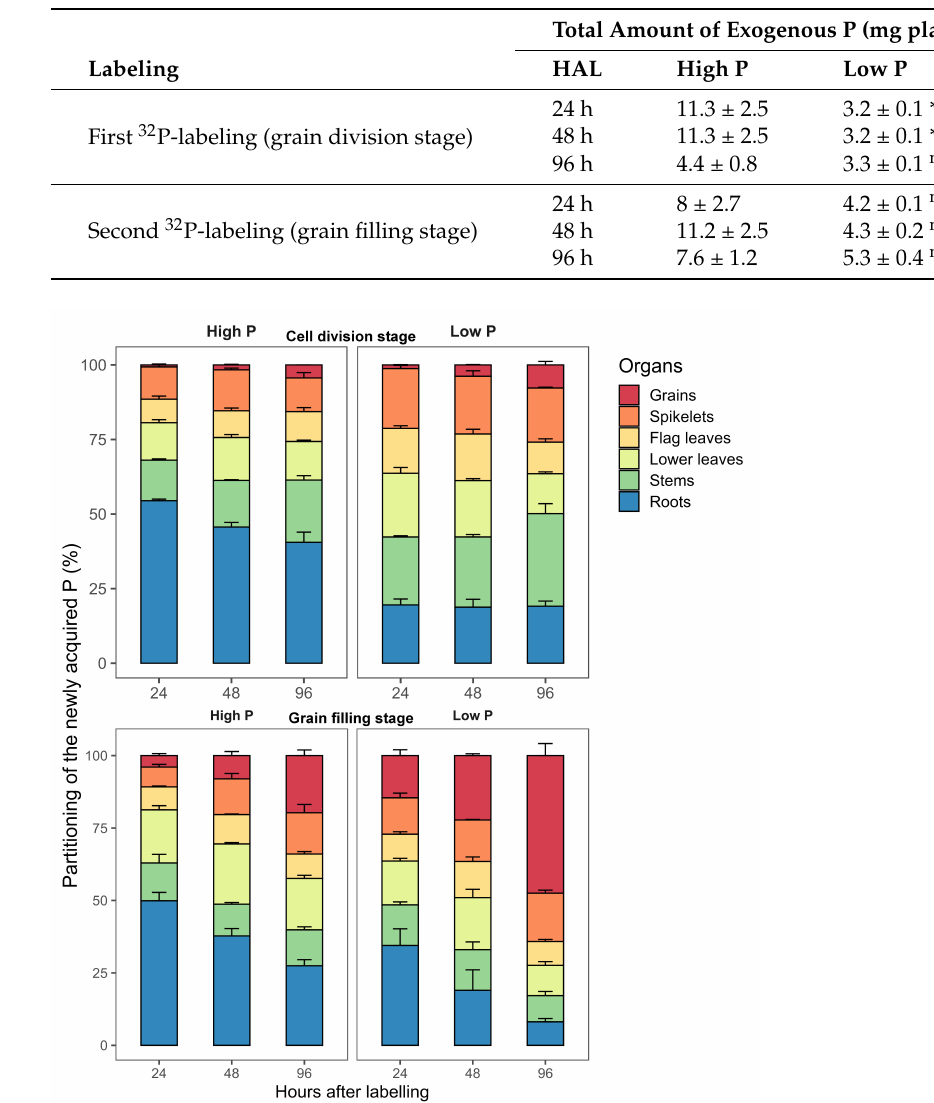
Table 1. Total P amount (mg P plant − 1 ) derived from exogenous P uptake during the two labeling experiments. Each labeling experiment lasted for 24 h. Values are mean ± standard errors of three replicates. HAL: hours after labeling. The asterisk represents a significant difference between high and low P treatments ( p < 0.05). ns: not significant.